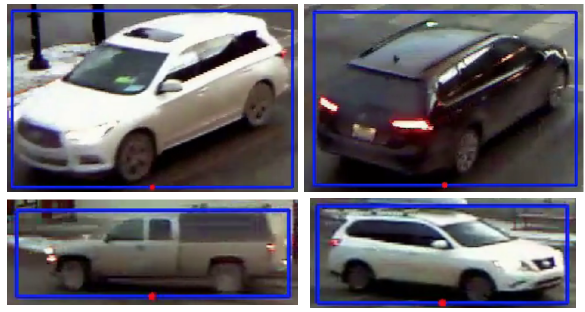
Figure 9. Vehicles center ground points